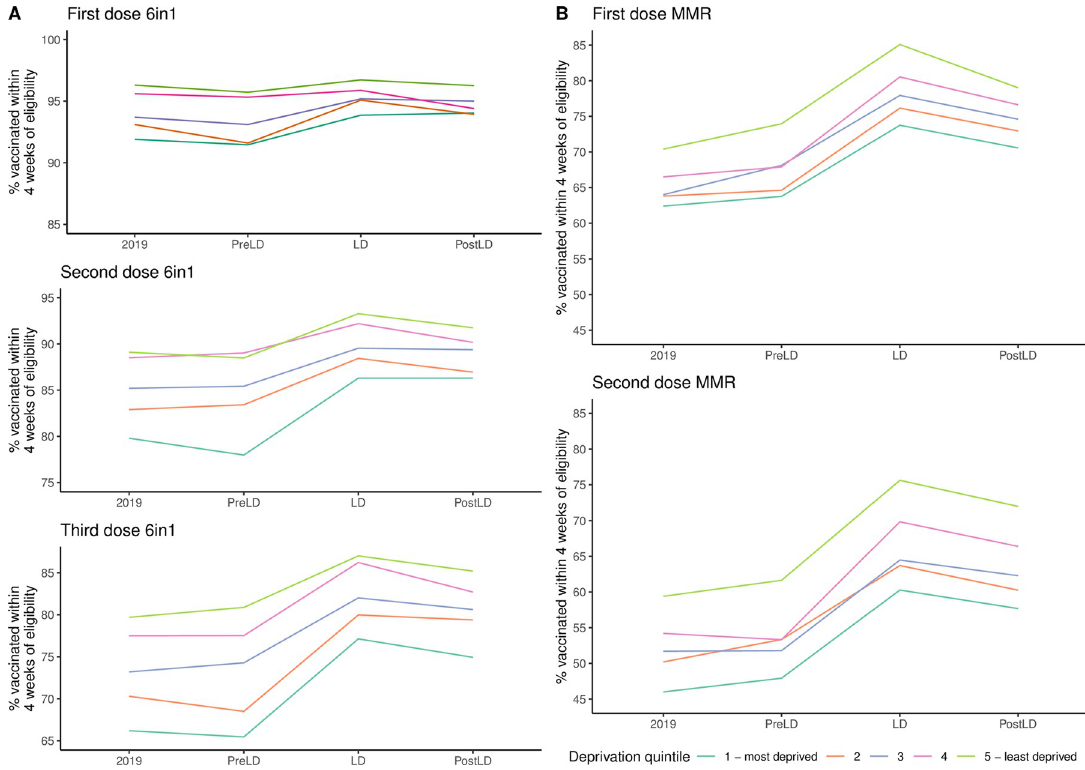
Fig 3. Mean percentage immunised by SIMD quintile in Scotland. (A) 6-in-1 vaccine; (B) MMR vaccine for Scotland. See S2 Fig and S4 Table for absolute percentage rise compared to 2019 and significance levels. LD, lockdown; MMR, measles, mumps, and rubella; PostLD, postlockdown; PreLD, prelockdown; SIMD, Scottish Index of Multiple Deprivation.